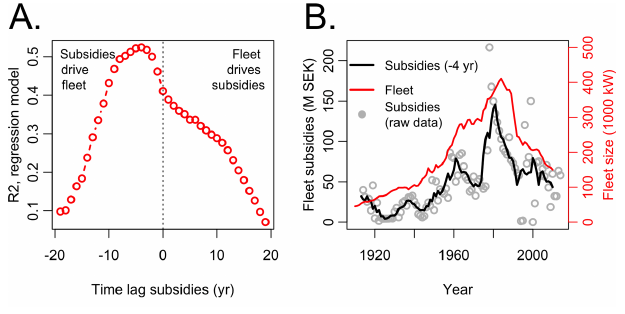
Fig. 4 . Temporal lags in capacity-enhancing subsidies and their effect on fishing fleet development. (A) Left panel shows R² for linear models having fleet size (Fig. 3B) as dependent variable, and capacity enhancing subsidies (Fig. 2, middle panel) as independent variable. The dotted line shows lag = 0, i.e., instantaneous response of the dependent variable on change of the independent variable. The peak in correlation occurs as -4 yr lag. (B) The two time-series, plotted with a -4 yr time lag. Grey circles denote the actual subsidies in a given year and the black line denotes a 5-year moving average of the subsidy level. The red line denotes the fleet size measured in 1000 kW. M SEK = millions, Swedish Krona.